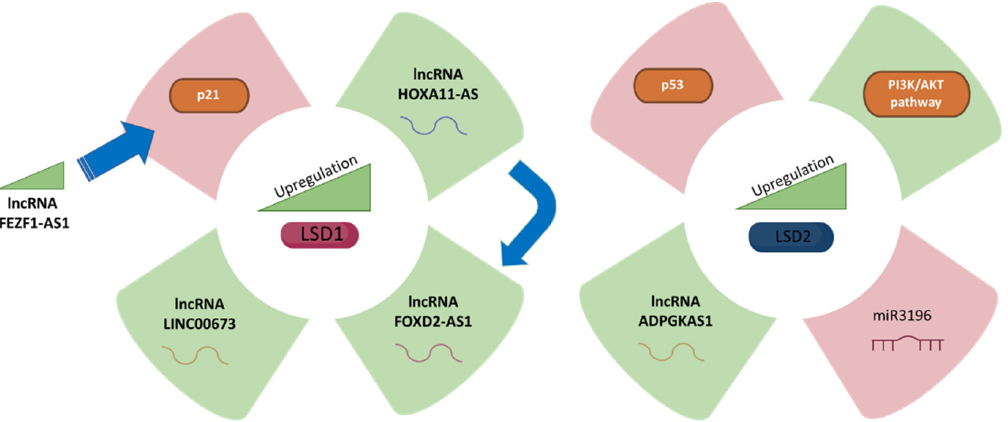
Figure 1. LSD1 ( left panel) and LSD2 ( right panel) expression and its correlation with gastric can ‐ cer fate. The green colour represents upregulation while purple represents downregulation of different molecules, which are related to LSD1 and LSD2 upregulation, respectively.